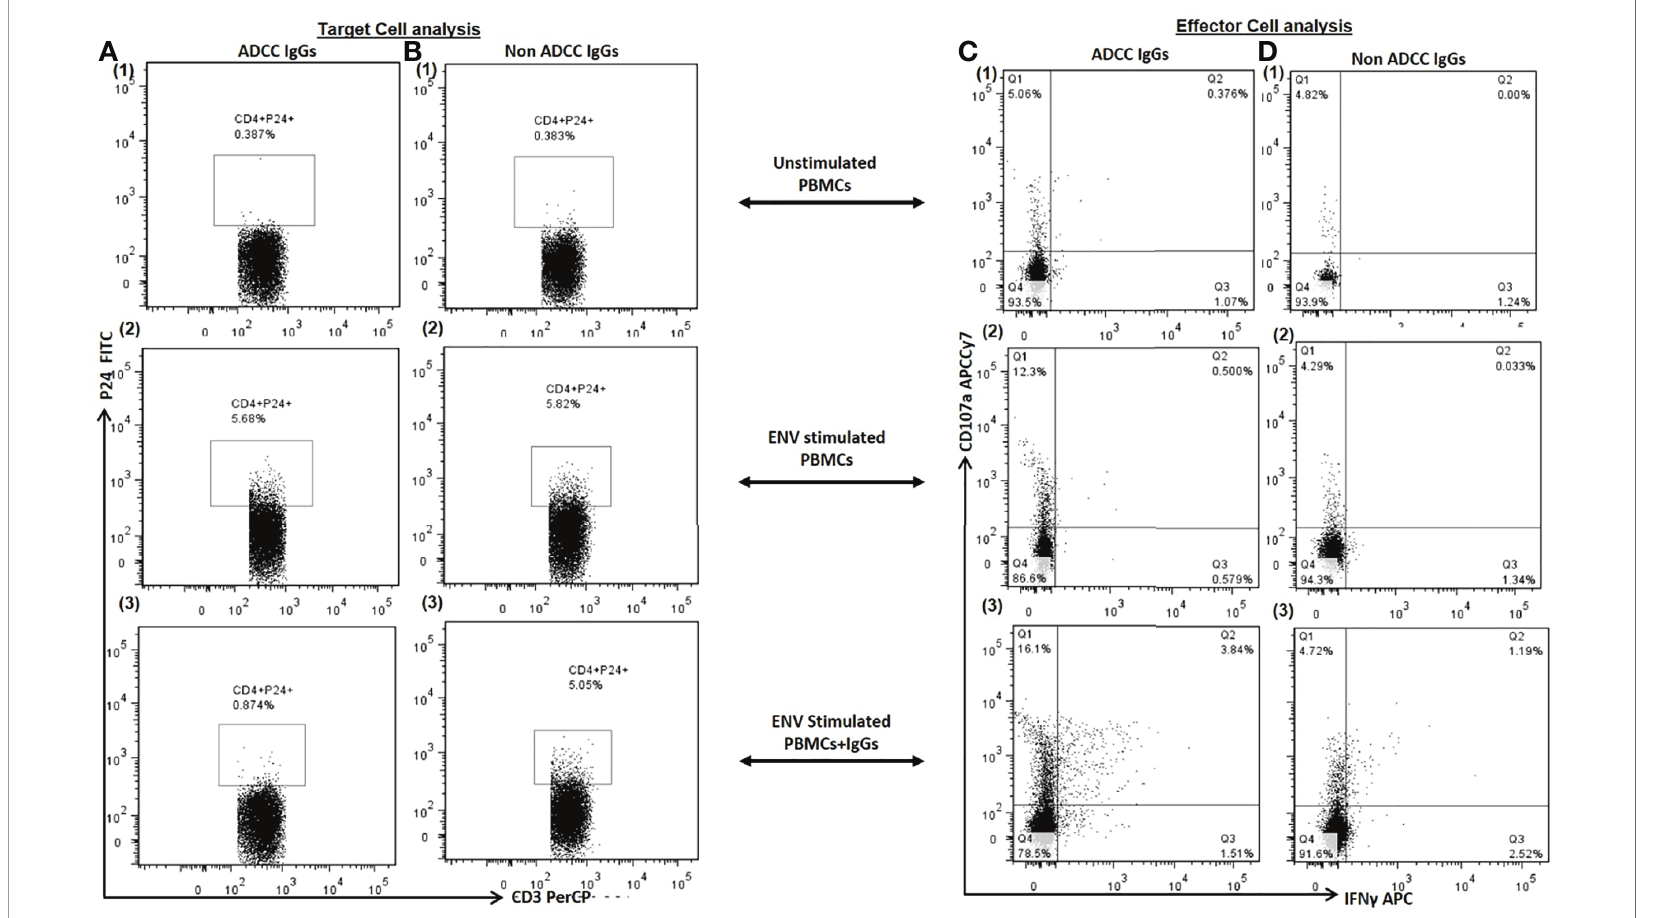
FIGURE 2 | Target Cell Analysis. The representative dot plots show frequency of p24+CD4+ cells (P24 on Y axis and CD3 on X axis) in (1) unstimulated PBMCs (as a source of both target: primary CD4+ T cells and effector: Nk cells) (2), Env stimulated PBMCs and (3) after addition of autologous ADCC IgGs in Env simulated PBMCs (Column A ) and after addition of autologous non ADCC IgGs (Column B ). Effector Cell Analysis. The representative dot plots show CD107a (on Y axis) and IFN g (on X axis) secreting NK cells in (1) unstimulated PBMCs (2), Env stimulated PBMCs and (3) after addition of autologous ADCC IgGs in Env simulated PBMCs (Column C ) and after addition of autologous non ADCC IgGs (Column D